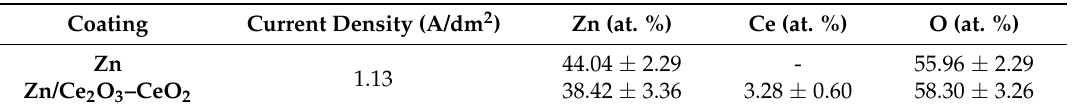
Figure 9. SEM image (×10,000) of the corrosion products generated on the scratch on the ratio area test 15:1: ( a ) Zn coating and ( b ) Zn/Ce 2 O 3 –CeO 2 coating. Table 3. Surface chemical composition obtained by EDX of the corrosion products generated on the scratch on Zn and Zn/Ce 2 O 3 –CeO 2 coatings.